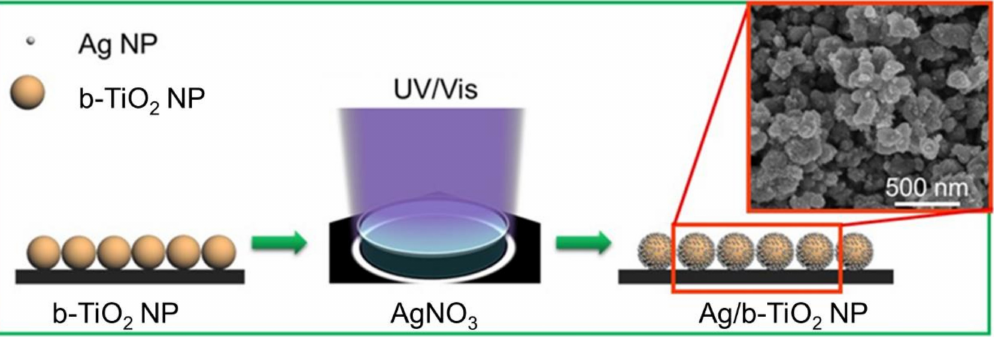
Figure 1. Schematic representation of the fabrication of Ag/b-TiO 2 .